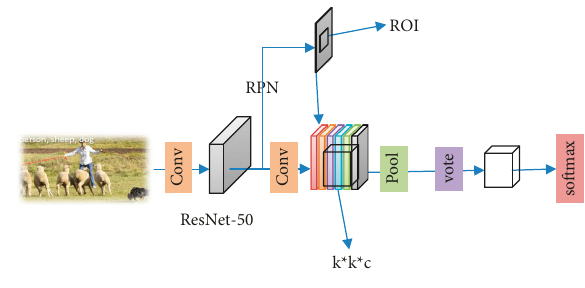
Figure 5: R-FCN structure.